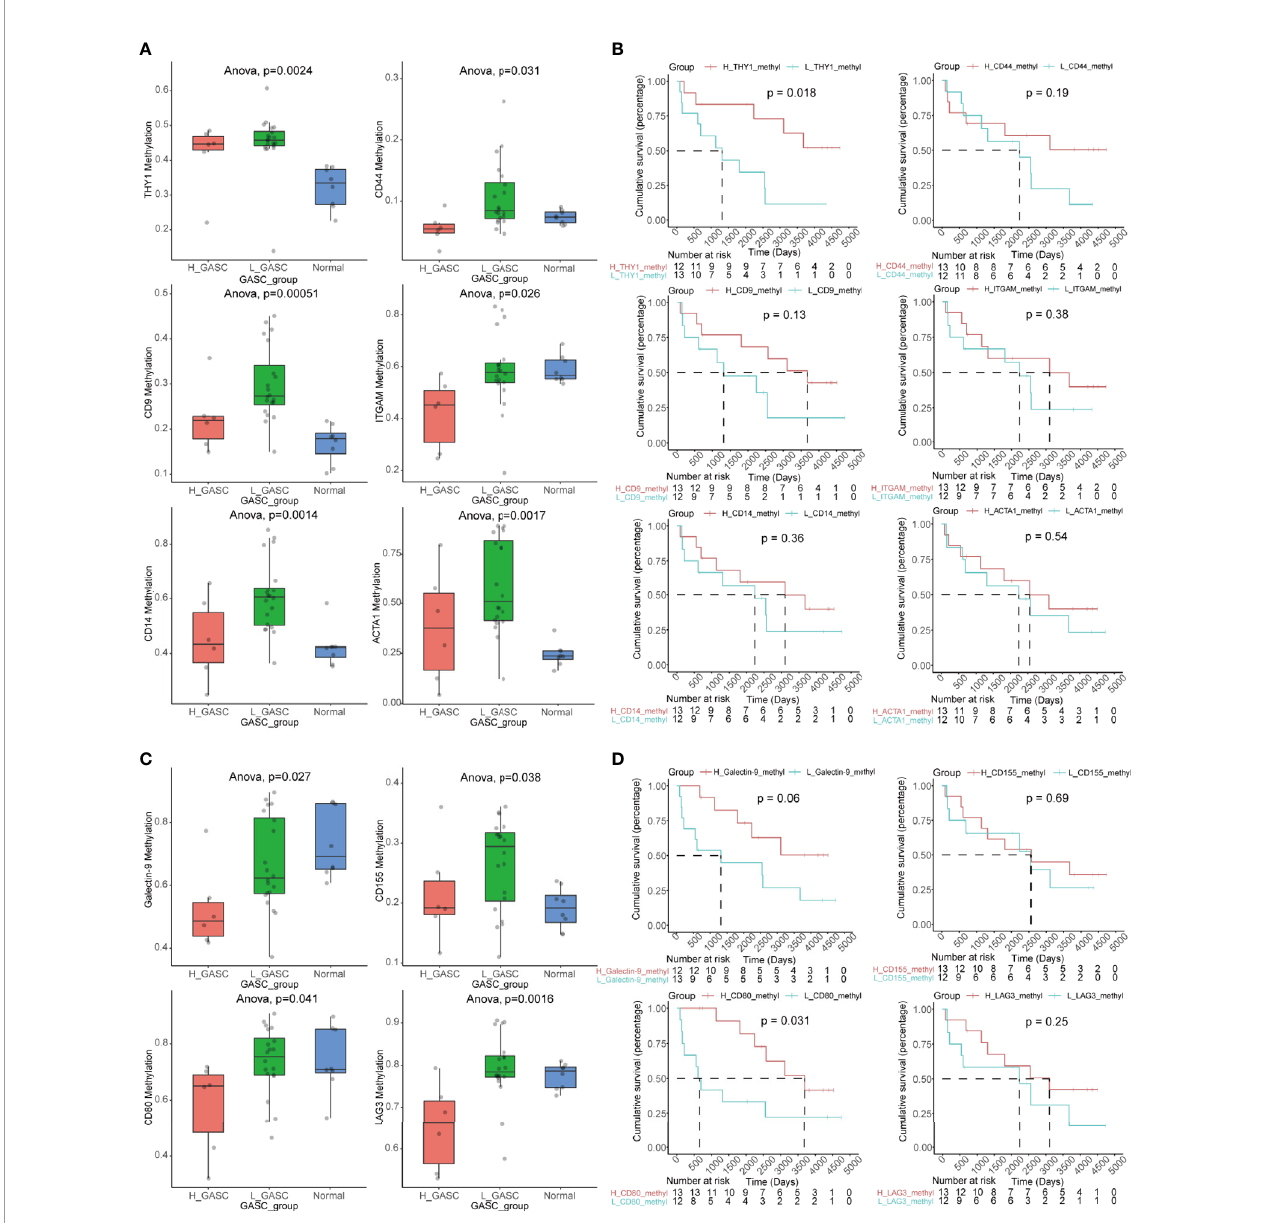
FIGURE 11 | Methylation analysis of GASC markers and ICPs. (A) Box plots illustrating the differences in THY1, CD9, CD14, CD44, ITGAM and ACTA1 methylation levels across high-GASC, low-GASC and normal groups. (B) Kaplan-Meier overall survival (OS) curves for samples in high- and low-methylation groups of THY1, CD9, CD14, CD44, ITGAM and ACTA1. (C) Box plots illustrating the differences in Galectin-9, CD80, CD155 and LAG3 methylation levels across high-GASC, low- GASC and normal groups. (D) Kaplan-Meier OS curves for samples in high- and low-methylation groups of Galectin-9, CD80, CD155 and